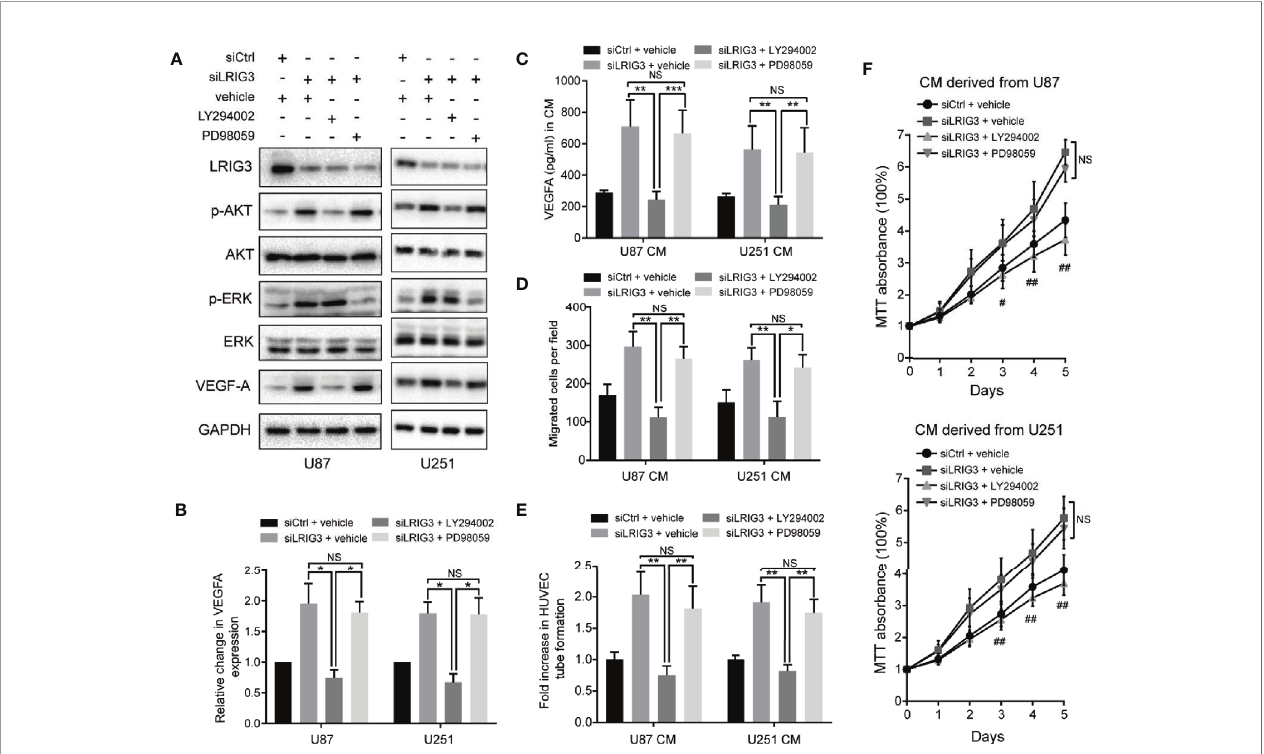
FIGURE 5 | LRIG3 modulates VEGFA expression via the PI3K/AKT signaling pathway. Western blots showing LRIG3, p-AKT, AKT, p-ERK, ERK, and VEGFA (A) alongside GAPDH (B) in the indicated glioma cells treated with the pathway inhibitors LY294002 (25 m M), PD98059 (10 m M), or DMSO vehicle for 24 h. (C) Levels of VEGFA protein in the CM from the indicated glioma cells were detected by ELISA. (D) Transwell migration assays in HUVECs treated with the indicated CM. (E) HUVECs formed tube-like structures with the indicated CM. (F) Cell viability of HUVECs was determined using the MTT assay. HUVECs were treated with the CM derived from the indicated cells for the speci fi c number of days. Data are means ± SD of 3 independent replicates. * p < 0.05; ** p < 0.01; *** p < 0.001; # p < 0.05, siLRIG3 + LY294002 versus siLRIG3 + vehicle and siLRIG3 + PD98059; ## p < 0.01, siLRIG3 + LY294002 versus siLRIG3 + vehicle and siLRIG3 + PD98059. CM, conditioned